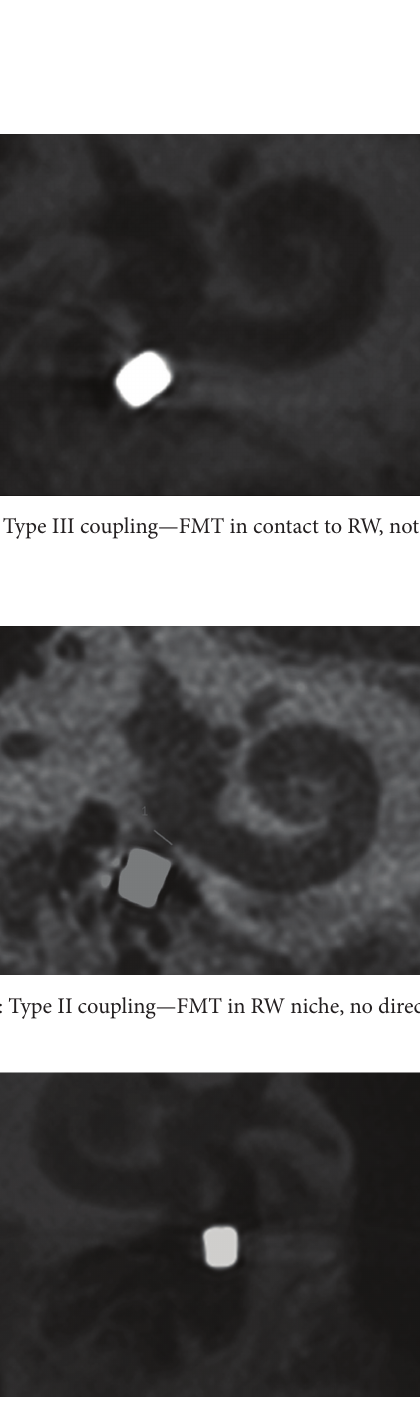
Figure 5: Type I coupling—FMT not in RW